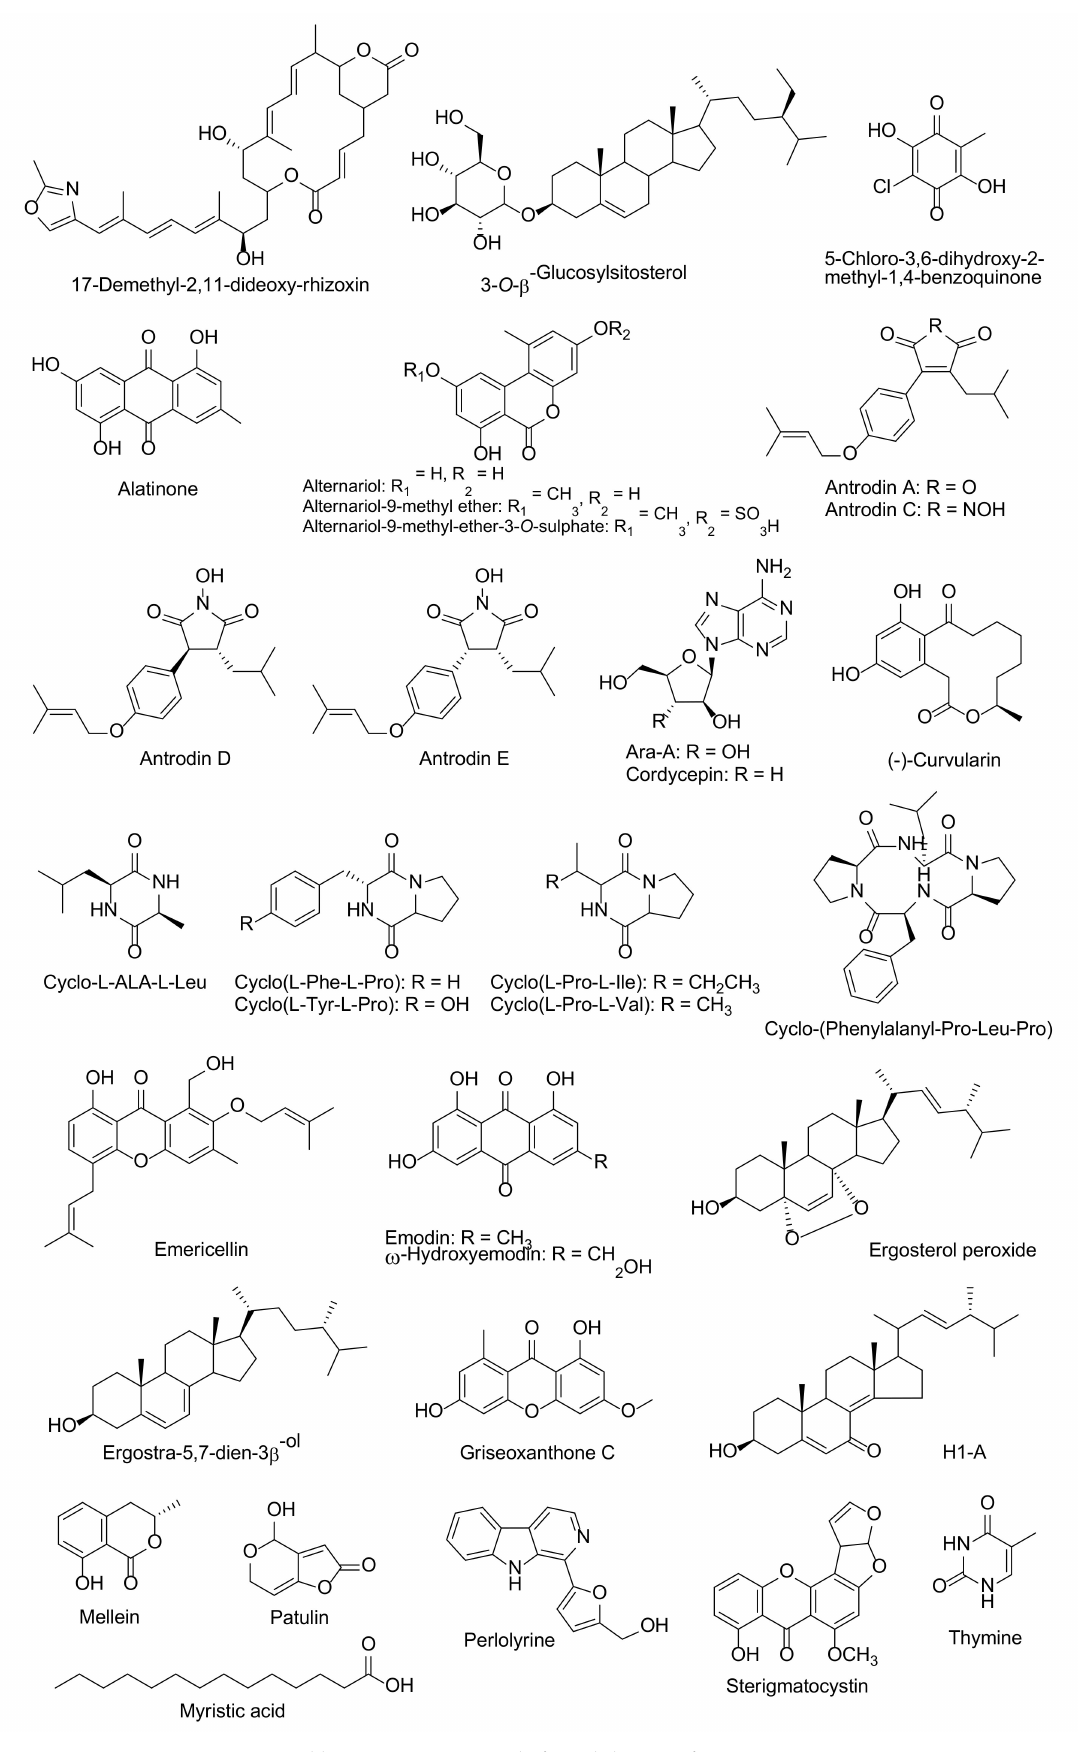
Figure 4. Fungal bioactive compounds for inhibition of HCV NS3 / 4A